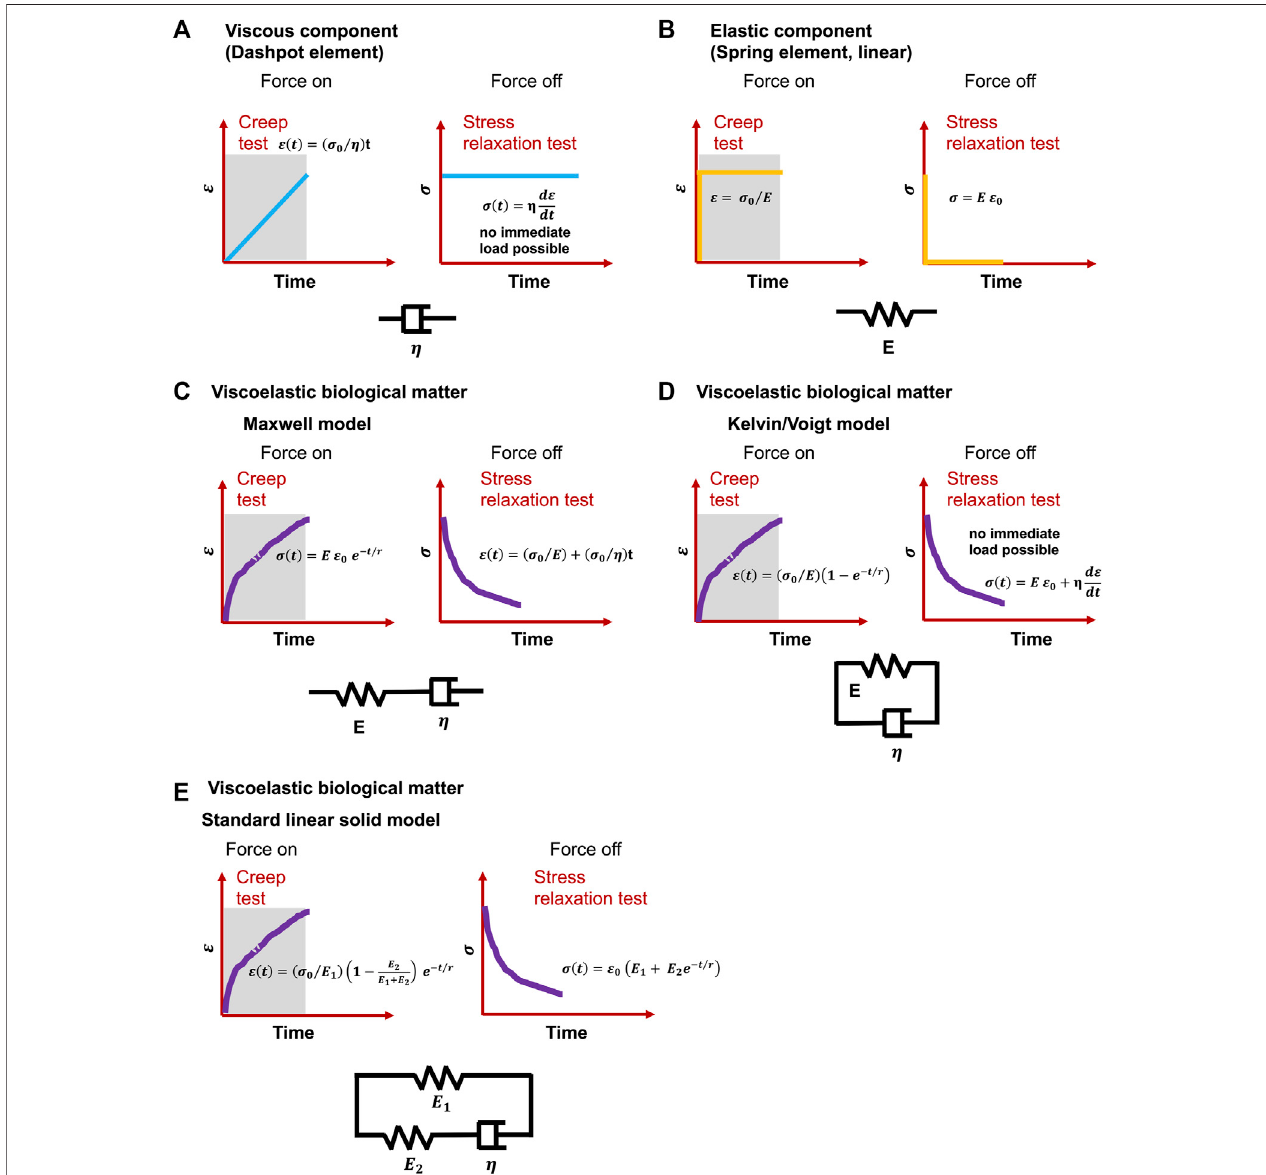
FIGURE2| Classical viscoelastic modelsfor creepand stressrelaxation testing caused byimmediate and constantstress σ 0 and strain ε 0 . (A) Spring element, (B) dashpot element, C-E) Cells undergo a material response when they are mechanically reshaped (deformed): (C) Maxwell model, (D) Kelvin or Voigt model and (E) Standard linear solid model. t is time, E represents the elastic modulus, η is the viscosity of dashpots and r denotes relaxation time.